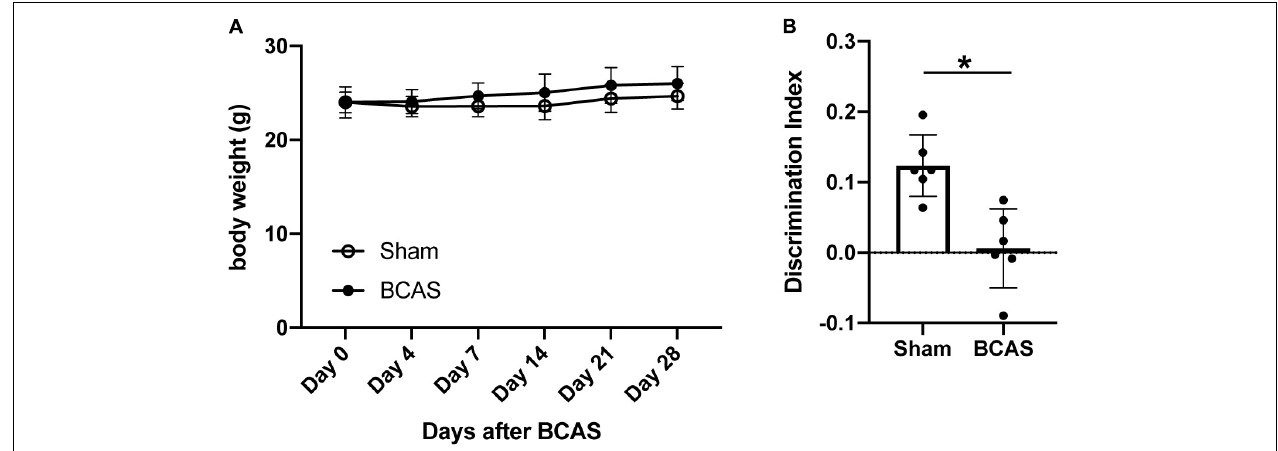
FIGURE 1 | Body weight changes and cognitive function after cerebral hypoperfusion. (A) Body weight changes after cerebral hypoperfusion. There was no significant difference between sham-operated and BCAS-hypoperfusion mice. Data are expressed as mean ± SD. N = 6 each. (B) Cognitive function was assessed by NORT at 4 weeks after sham or BCAS operation. While sham-operated mice accessed the novel object, BCAS-hypoperfusion mice did not show any preference between the novel and familiar objects. Data are expressed as mean ± SD. N = 6 each. * p <